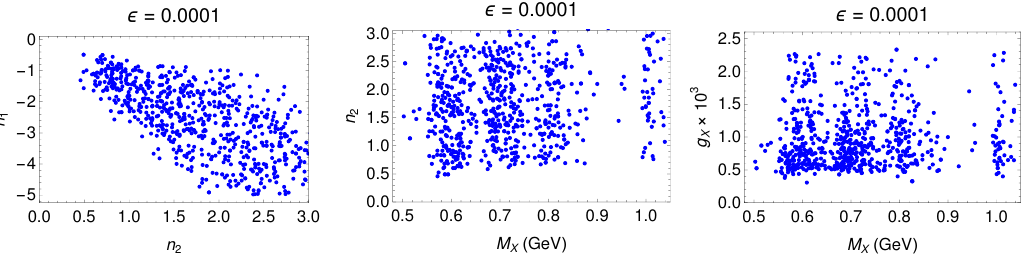
Figure 5 . The allowed parameter spaces for n 1 , n 2 , g X and M X which passes the constraints from R ( K ( ∗ ) ) , the anomalous magnetic moment of the muon and B ( B → K ( ∗ ) µµ ) . Note that the observables in b → s‘‘ decays are defined in high ( 1 . 1 < q 2 < 6 . 0 (GeV 2 )) as well as in the low- q 2 ( 0 . 045 < q 2 < 1 . 1 (GeV 2 )) regions.